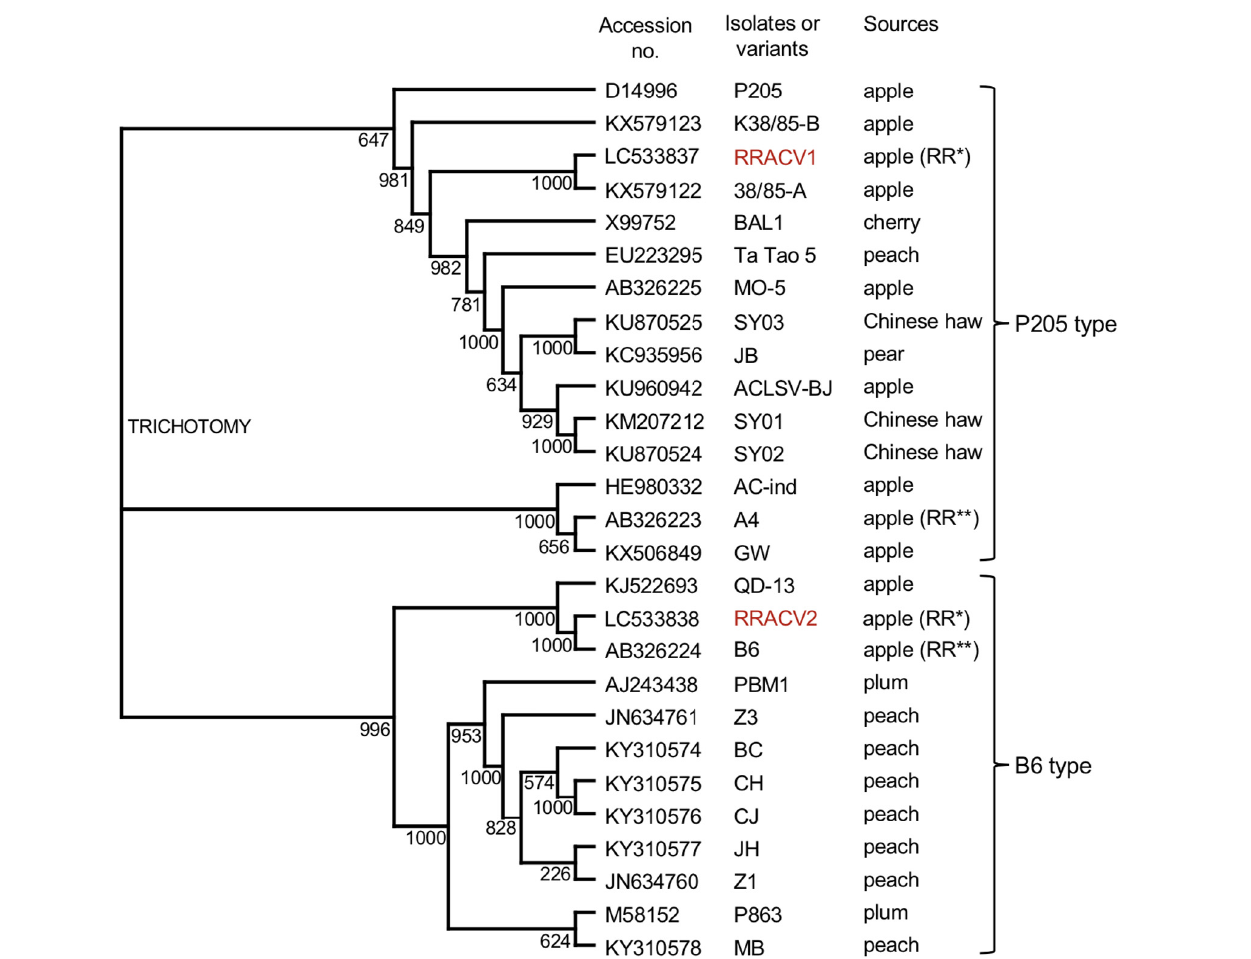
FIGURE 3 | Phylogenetic tree based on the complete nucleotide sequences of ACLSV genomes. The tree was generated by CLUSTALW program (DNA databank of JAPAN [DDBJ]; URL: http://clustalw.ddbj.nig.ac.jp/). Bootstrap values for each node are shown (1000 replicates). Sequence variants analyzed in this study are shown in red. Apple (RR*) indicated an apple tree affected with ARRD used in this study and apple (RR**) is an another apple tree affected with ARRD described before (Yaegashi et al.,